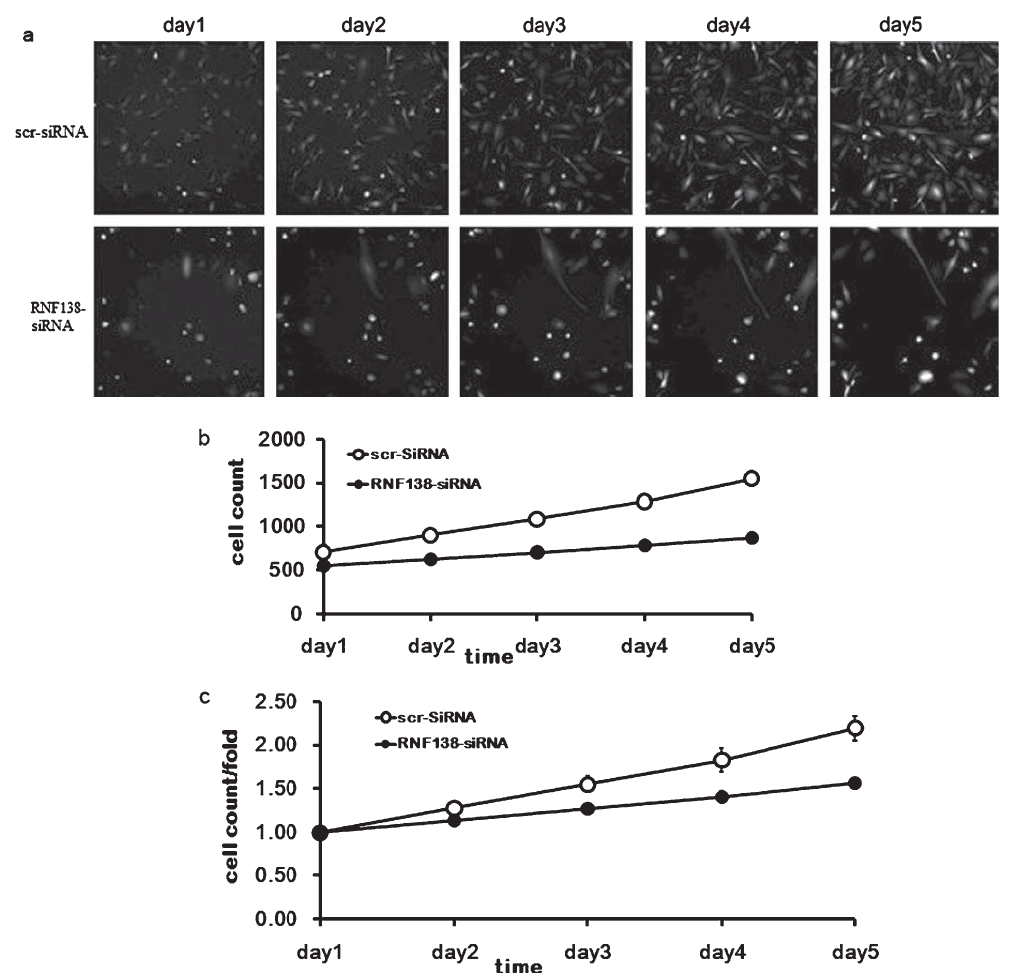
Fig. 5. Effect of down-regulation of RNF138 on cell proliferation: (a) RNF138-siRNA targeted cells and negative control cells were observed by cellomics for 5 days. The cell proliferation ability was significantly inhibited in RNF138-RNAi cells as compared with that negative control cells. (b) cell count curve of RNF138-siRNA targeted cells and negative control cells. (c) cell count/fold curve of RNF138-siRNA targeted cells and negative control cells. These results indicate that knockdown of RNF138 expression significantly inhibits the U251 cells growth.